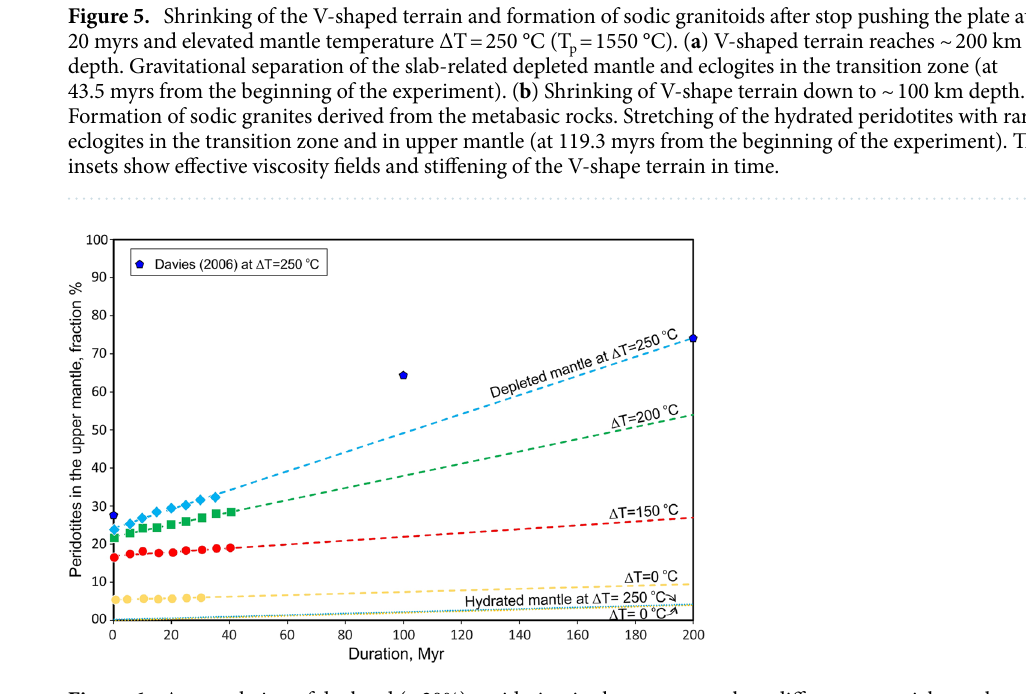
Figure 6. Accumulation of depleted (> 20%) peridotites in the upper mantle at different potential mantle temperatures ΔT = 0–250 °C. Filled circles, quadrangles and diamonds are results of our numerical experiments, related dashed lines—linear fit to the points from the numerical model results. Blue pentahedrons show the modeling results by Davies 26 at ∆T = 0–250